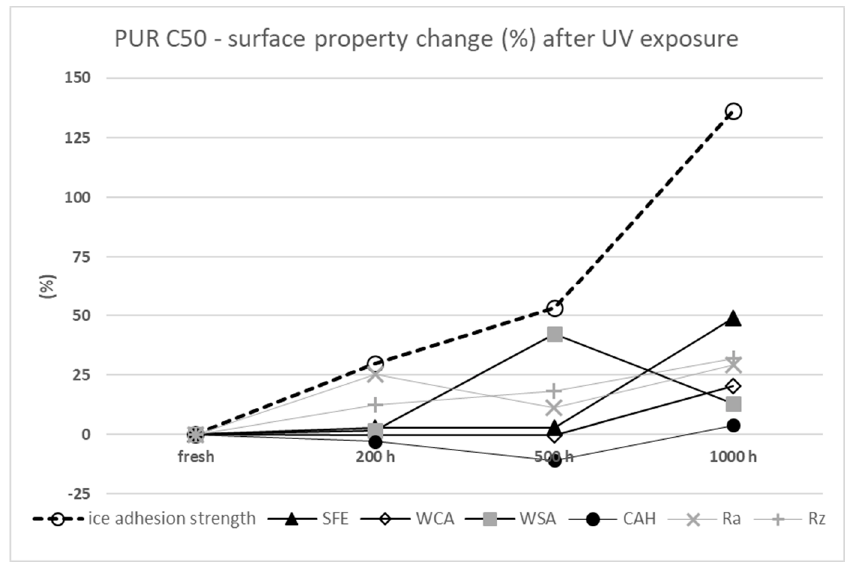
Figure 8. Change in surface properties and ice adhesion strength (%) due to UV(B)-ageing of the coating “PUR C50” (maximum value of y -axis 150%). coating “PUR C50” (maximum value of y -axis